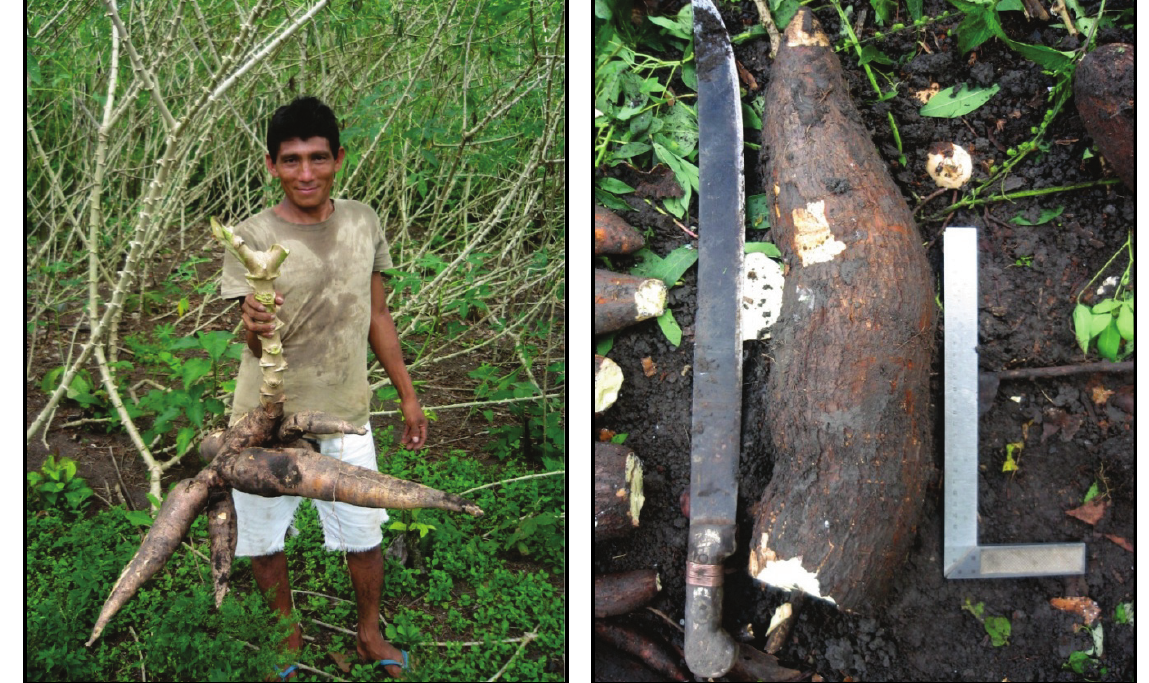
Figure 2. Yields of certain bitter manioc landraces are better in ADE. The tuberous roots of landraces “Tartaruga,” (left) harvested from ADE 7.5 months after planting at Monte Sião and “Pirarucu Branco” (right) harvested from ADE 16 months after planting at Barreira do Capanã. Photos by the author